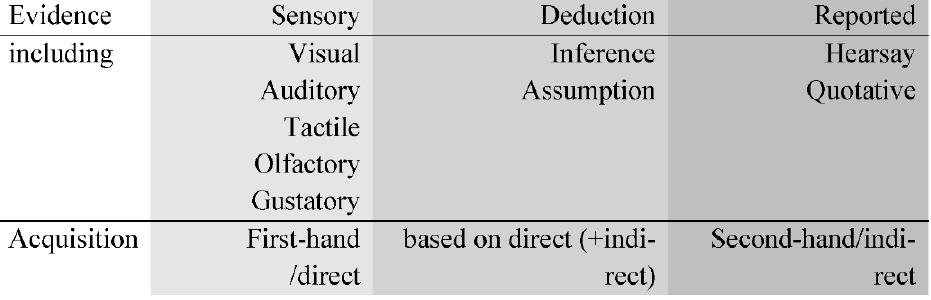
Figure 1. Comprehensive evidence acquisition